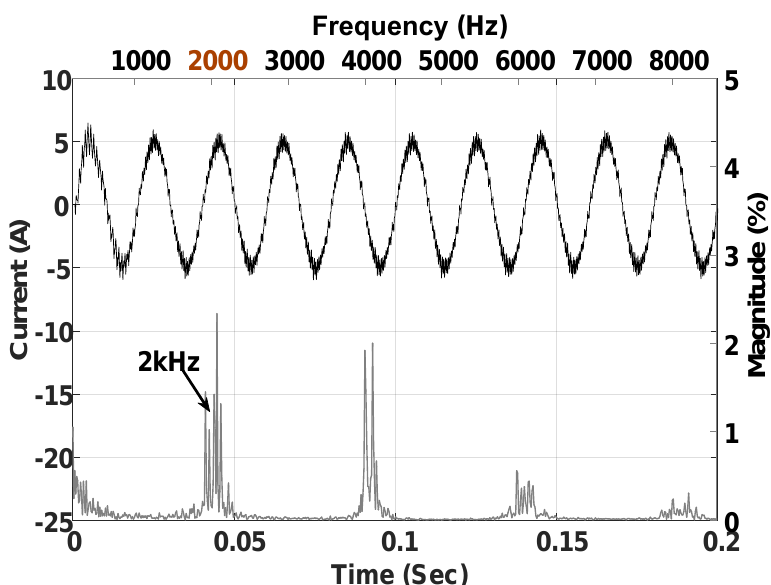
Figure 11. Experimental results of output load current (phase a) with its corresponding spectrum utilizing periodic control (P-CMPC).